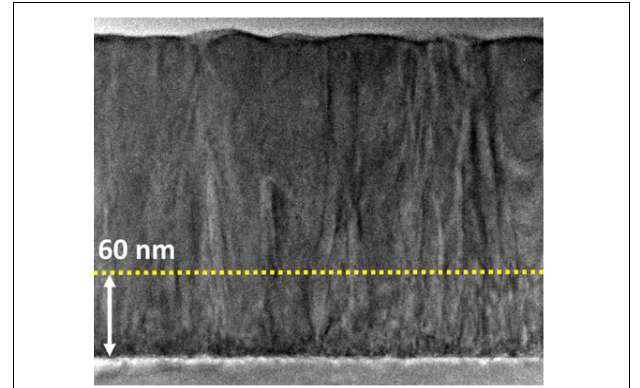
FIGURE 5 | Cross-sectional, bright field, TEM image taken along the < 110 > direction of a representative Ge 1 − x Sn x film shows a ∼ 60 nm thick interface layer with a high density of stacking faults as well as misfit dislocations at the interface with the substrate. Above this interface layer, the crystalline quality improves dramatically and the defect density is greatly reduced.